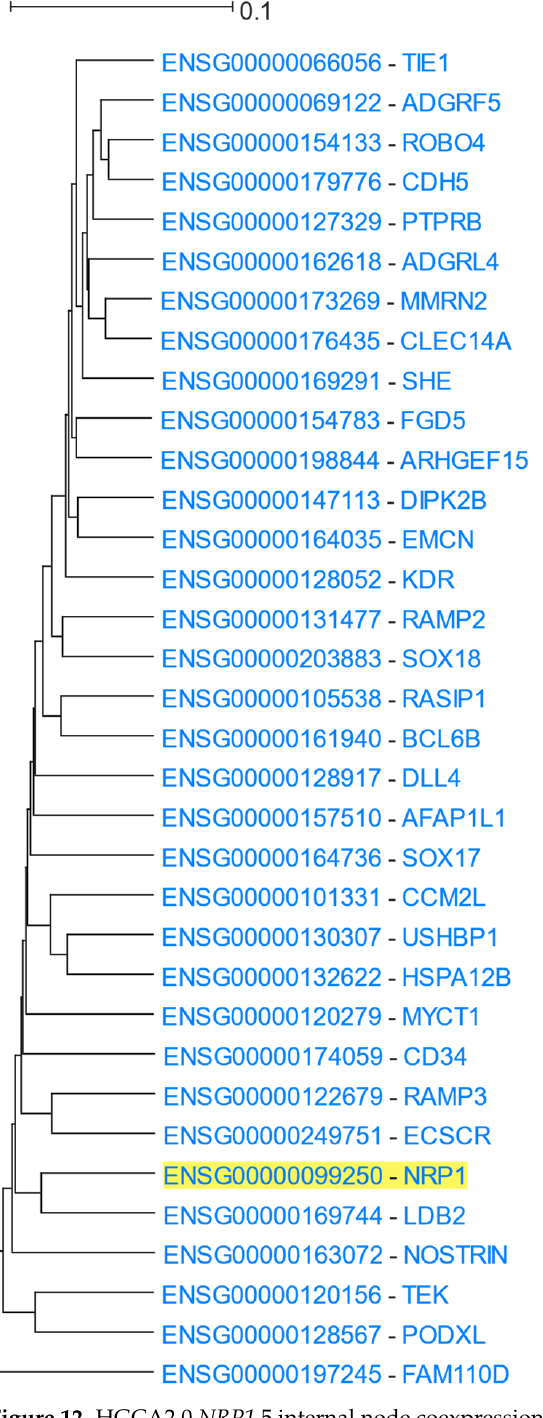
Figure 12. HGCA2.0 NRP1 5 internal node coexpression clade.